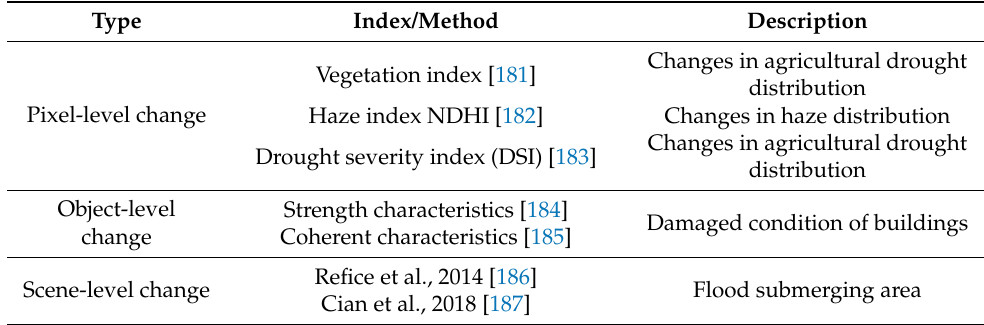
Table 12. The application of change detection.